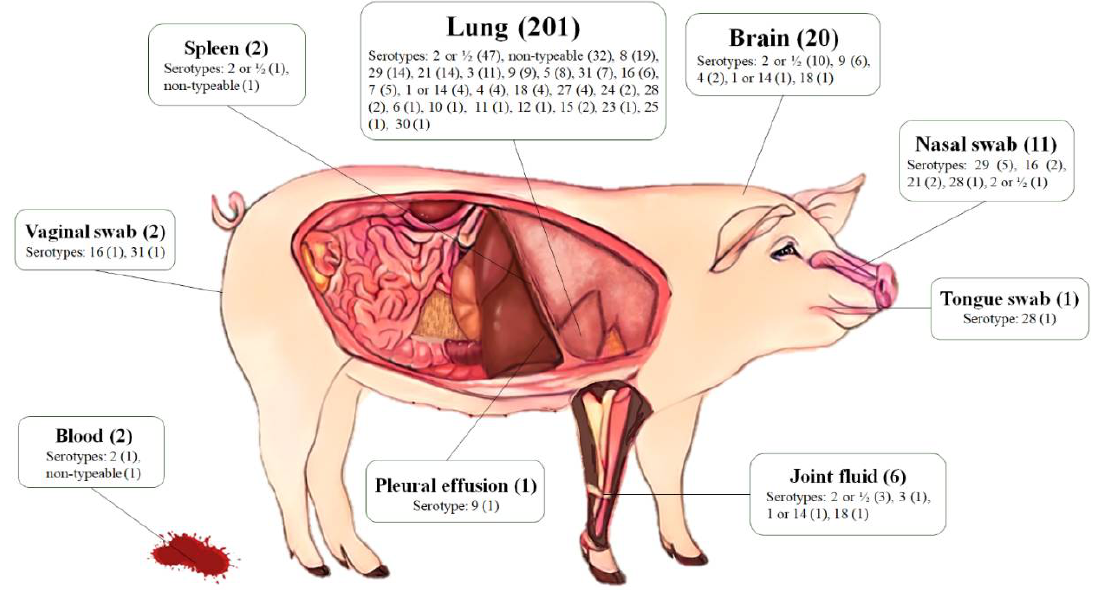
Figure 2. Anatomical origin of 246 S. suis strains and their serotype distribution. Lung ( n = 201, 81.7%), brain ( n = 20, 8.1%), nasal swab ( n = 11, 4.5%), joint fluid ( n = 6, 2.4%), blood ( n = 2, 0.8%), spleen ( n = 2, 0.8%), vaginal swab ( n = 2, 0.8%), pleural effusion ( n = 1, 0.4%), and tongue swab ( n = 1, 0.4%) samples were collected.